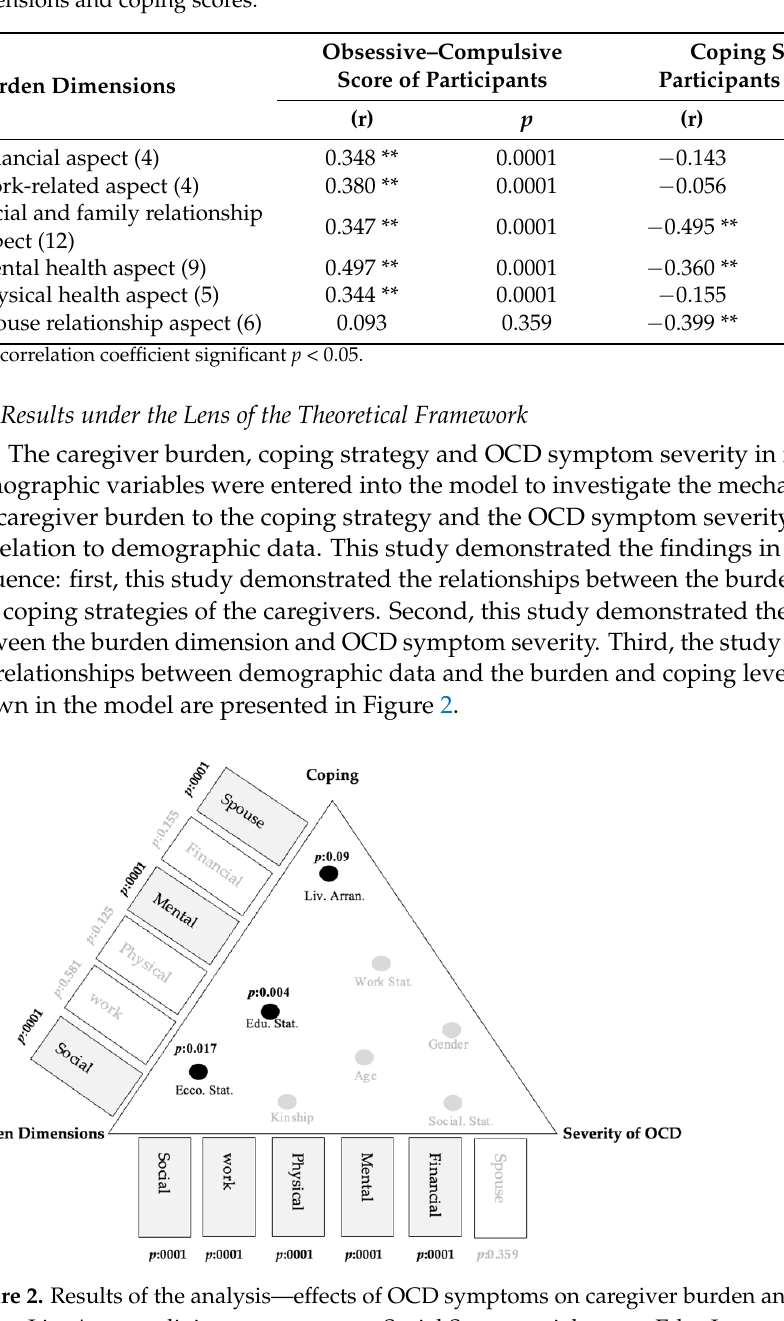
Table 3. Correlation between the OCD symptom severity of OCD participants, caregivers’ burden dimensions and coping scores.